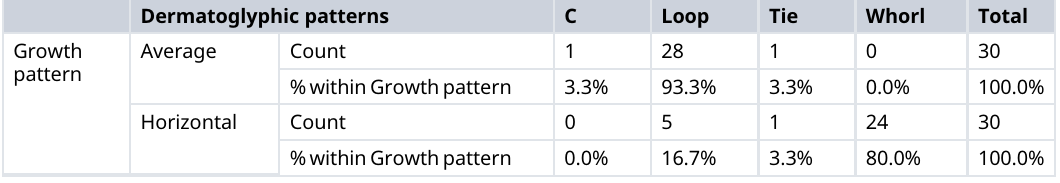
Table 2. The Fisher ’ s exact test between the average and horizontal groups (Left hand).